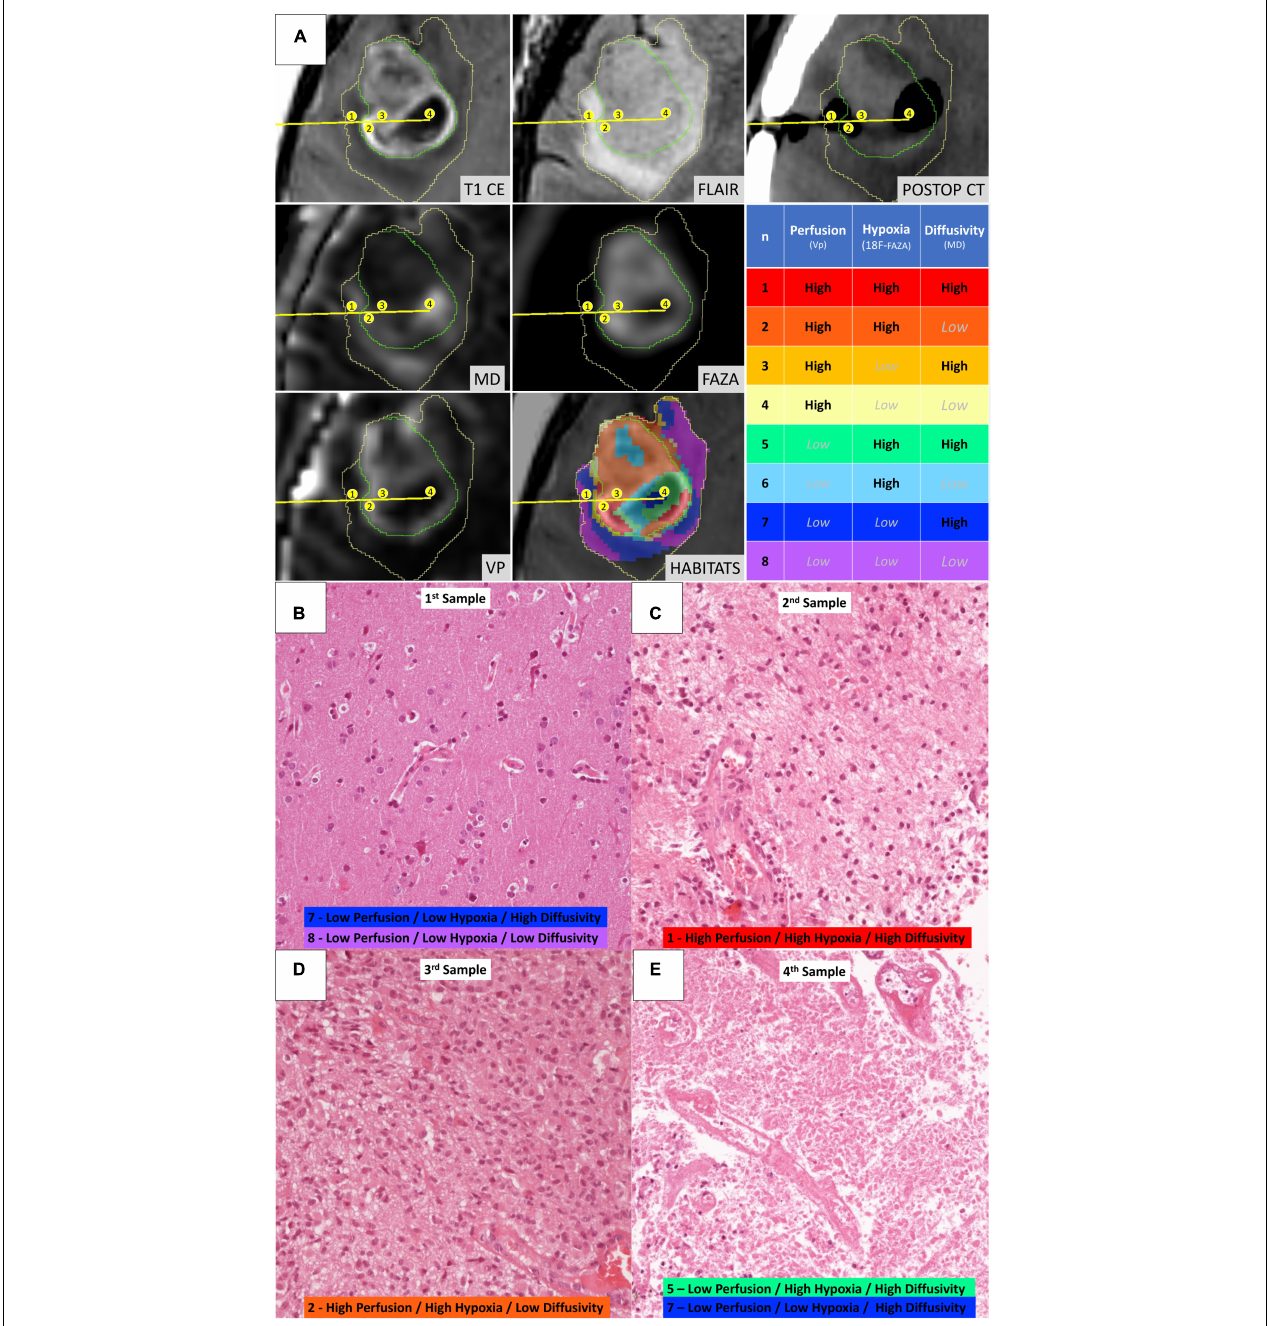
FIGURE 5 | Illustrative case of a 57-year-old female patient (case 16 in Table 1 ) who underwent stereotactic biopsy. (A) The trajectory path (yellow line) and the four consecutive sampling sites (enumerated in the yellow circles) are displayed in axial formatted pre-operative T1-CE, FLAIR, MD, 18 F-FAZA, Vp, and post-operative CT images; the spatial distribution of the identified habitats and the assigned key colors are also displayed (1–red, 2–orange, 3–gold, 4–yellow, 5–aquamarine, 6–light blue, 7–dark blue, and 8–violet). (B) Microscopic slide [20 × magnification, Hematoxylin and Eosin (H&E)] from the first sampling (corresponding to Habitat 7–Low Perfusion/Low Hypoxia/High Diffusivity and Habitat 8–Low Perfusion/Low Hypoxia/Low Diffusivity) showing a cortical/subcortical area with normal tissue architecture, presence of normal vessel and no significant increase in cellularity, but rather mild reactive gliosis. (C) Microscopic slide (20 × magnification, H&E) from the second sampling (Habitat 1–High Perfusion/High Hypoxia/High Diffusivity) showing a clearly pathological area of white matter with increased cellularity, disruption of the physiological tissue architecture, and abnormal vessels. (D) Microscopic slide (20 × magnification, H&E) from the third sampling (Habitat 2–High Perfusion/High Hypoxia/Low Diffusivity) showing neoplastic tissue with cytoarchitecture disruption, elevated cellularity with the presence of gemistocytic astrocytes, nuclear atypia, abundant eosinophilic cytoplasm, abnormal vascularization. (E) Microscopic slide (20 × magnification, H&E) from the fourth sampling (Habitat 5–Low Perfusion/High Hypoxia/High Diffusivity and Habitat 7–Low Perfusion/Low Hypoxia/High Diffusivity) showing tissue with extensive necrosis.